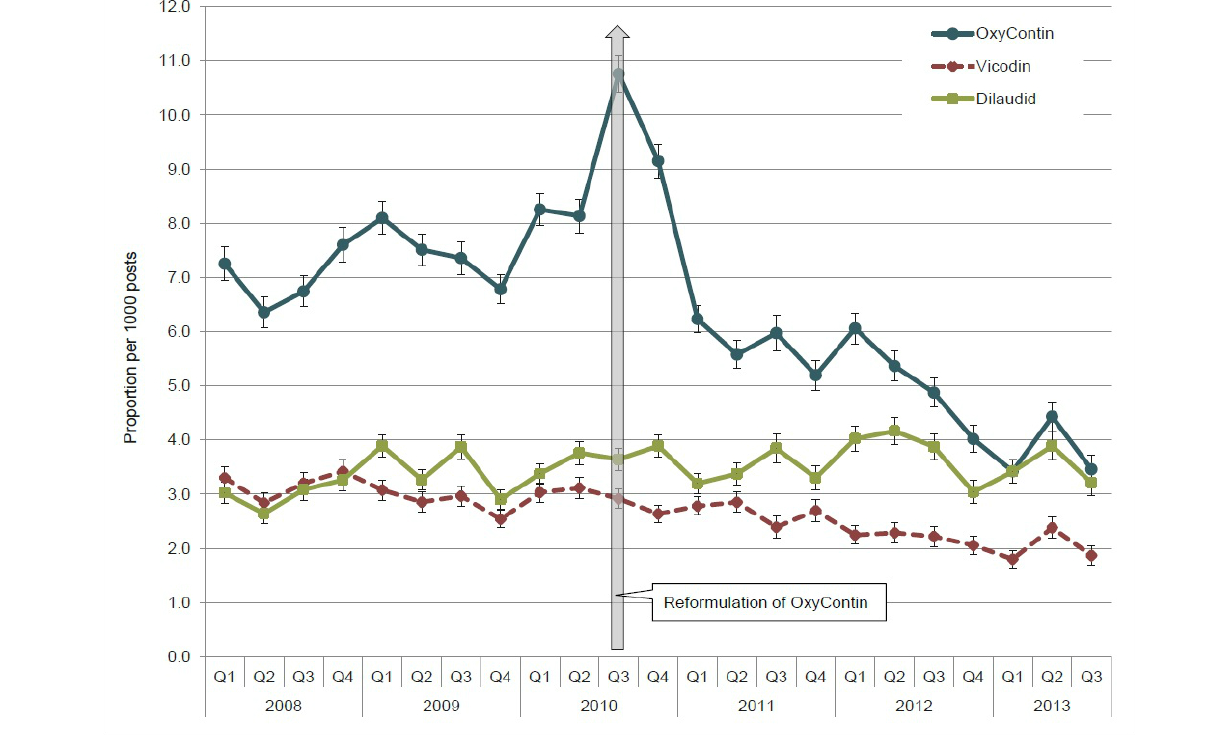
Figure 2. Proportion of OxyContin-, Vicodin-, and Dilaudid-related posts from Q1 2008 to Q3